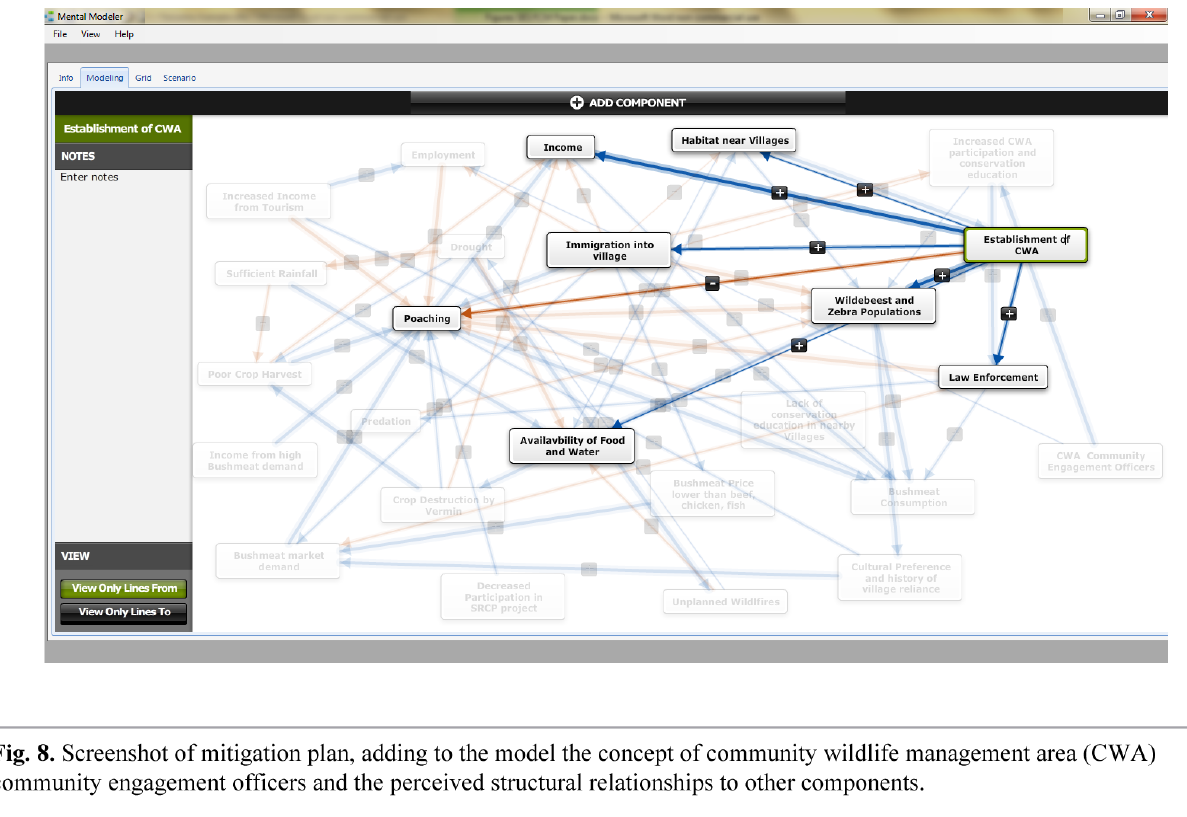
Fig. 7 . Screenshot of mitigation plan, adding to the model the concept of establishment of community wildlife management area (CWA) and its perceived structural relationships to other